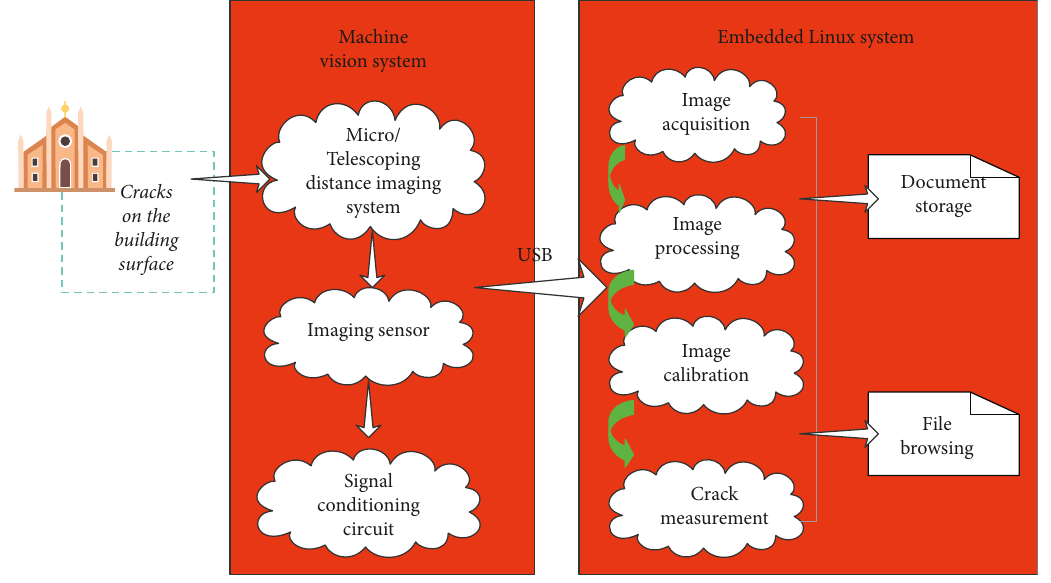
Figure 2: Overall scheme of the